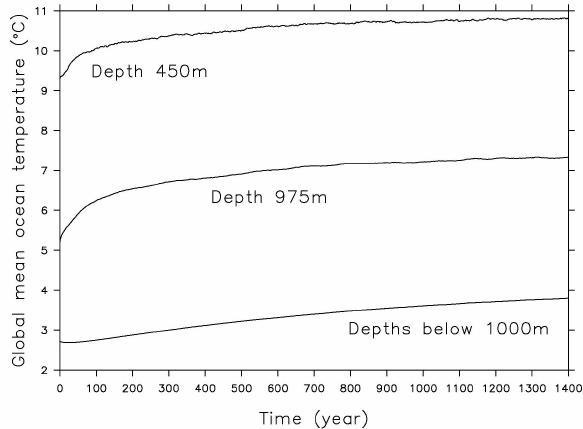
Fig. 7. Time series of the globally averaged value of the AOGCM ocean temperature at various